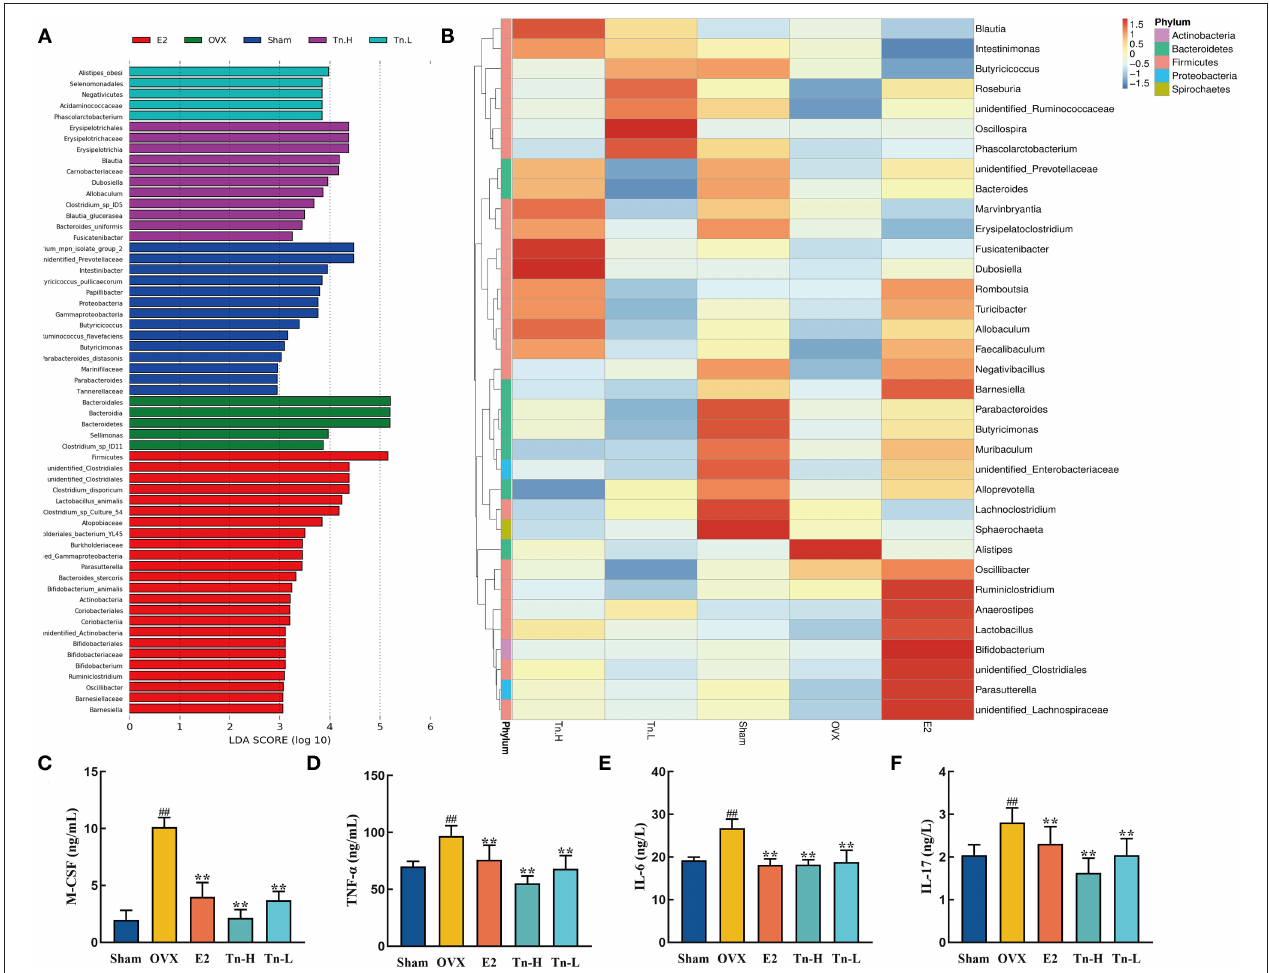
FIGURE 4 | THLs reduced inflammation by altering gut microbiota in OVX rats. LEfSe was applied to analyze the biomarker bacteria for each of groups. LDA score (A) is greater than the set value (the default setting is 4), that is, the biomarker with statistical difference between the groups. Species abundance of the genus level was showed in clustering heatmap (B) . The abscissa is used to display the names of samples or groups, and the ordinate on the right is used to display the names of bacteria. The deeper the red color, the higher the abundance of the bacteria; the deeper the blue color, the lower the abundance of the bacteria. M-CSF (C) , TNF- α (D) , IL-6 (E) , and IL-17 (F) levels in the serum of rats were determined by ELISA. Tn-H, high-dose THLs group; Tn-L, low-dose THLs group. ** p < 0.01 vs. OVX group; ** p < 0.01 vs. OVX